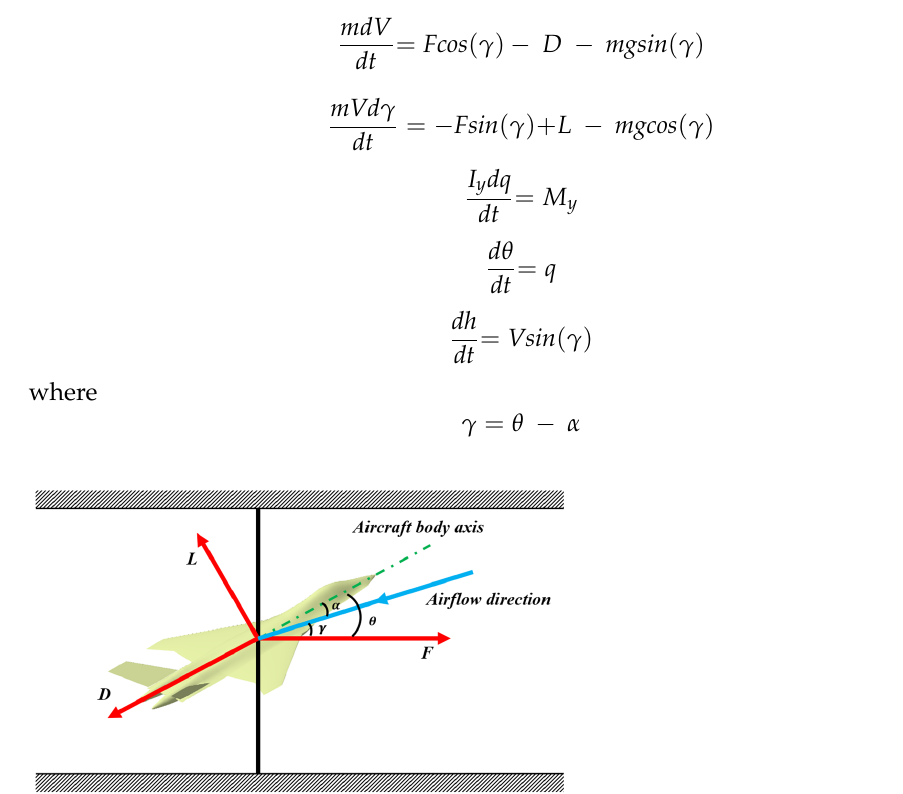
Figure 15. V-tail actuator and its force analysis process.